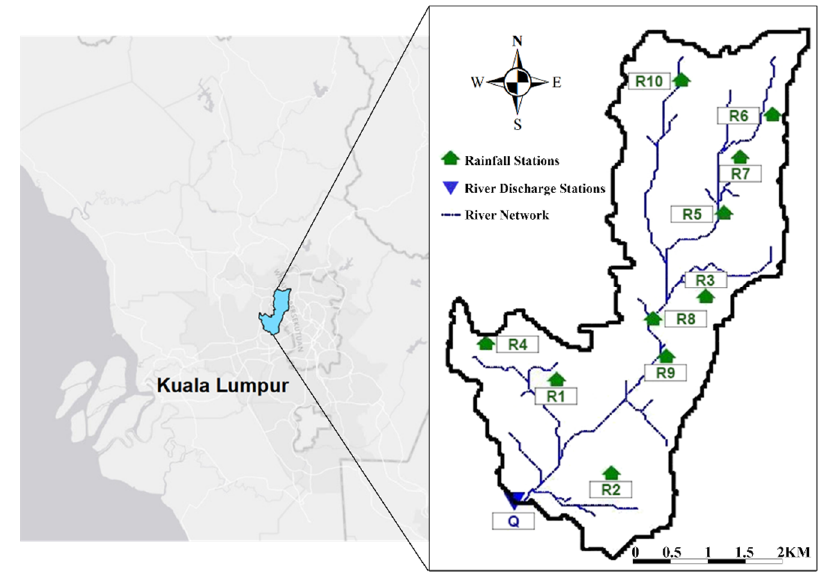
Figure 1. Schematic map of Sungai Kayu Ara catchment.